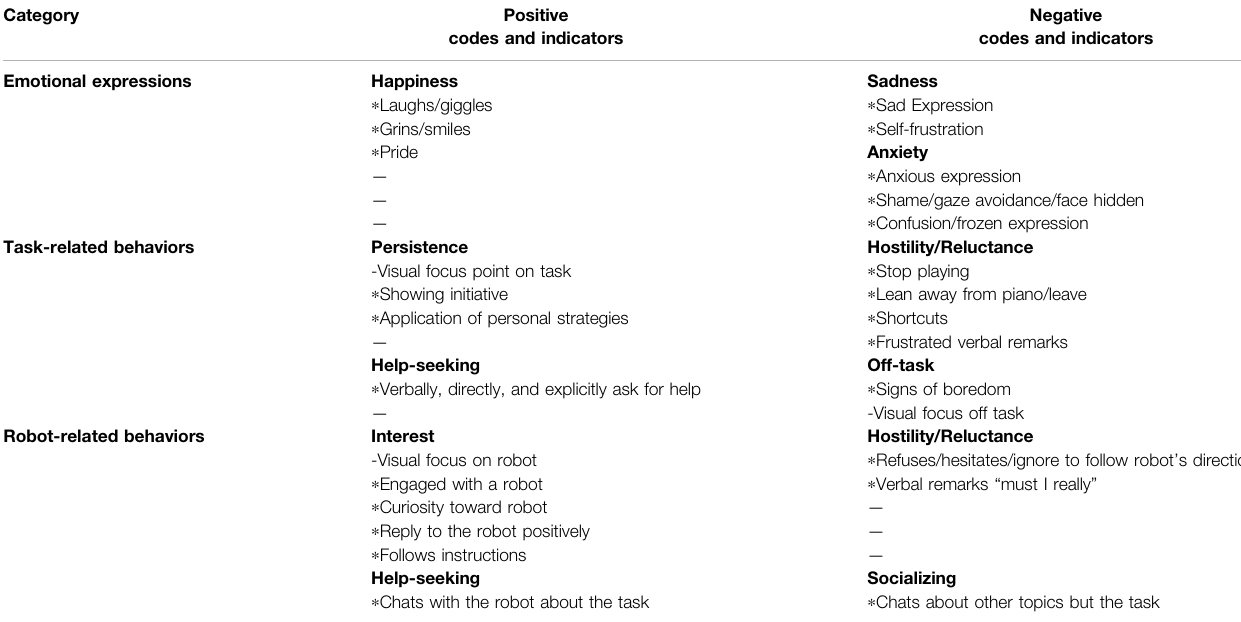
TABLE 3 | Descriptions for Emotion and Task Behavior Codes.